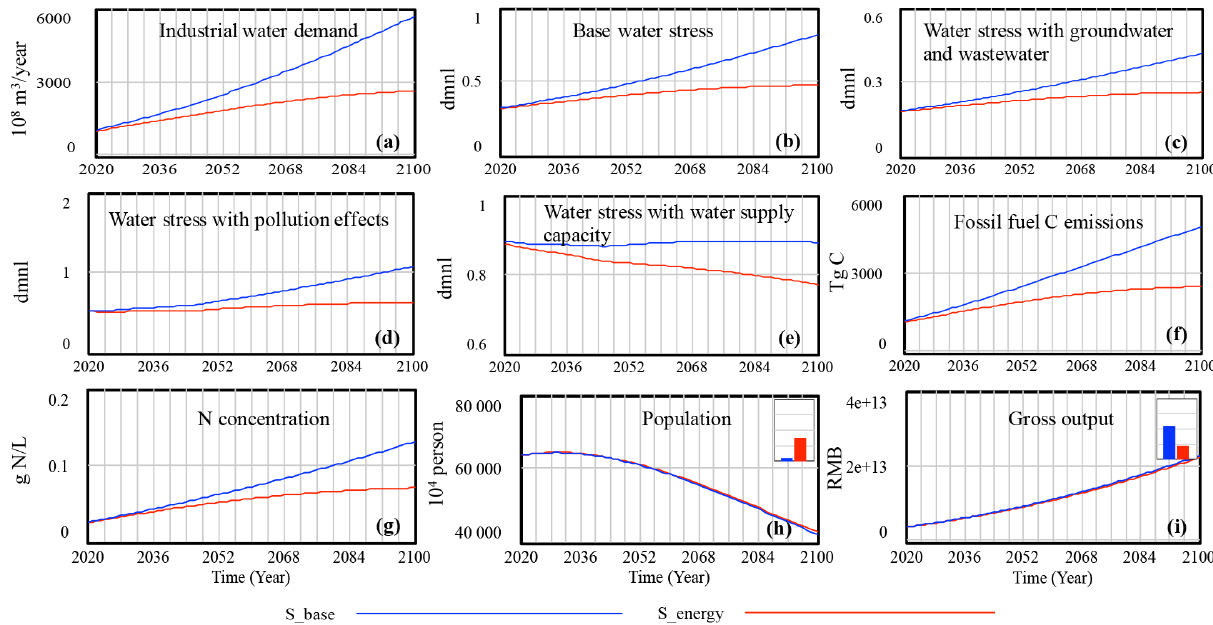
Figure 20. Effects of energy policy on the Belt